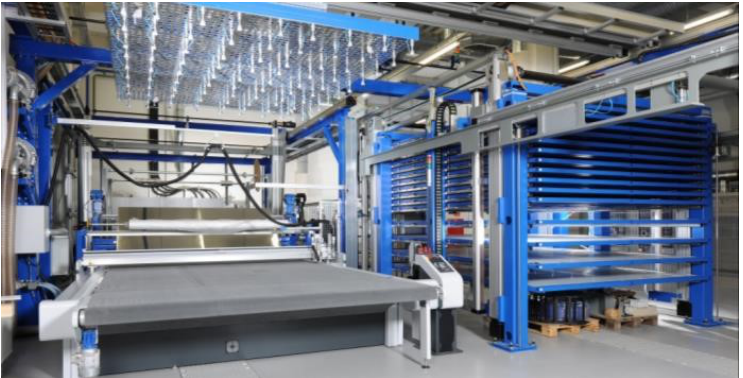
Figure 2: Cutter, storage and ply handling.